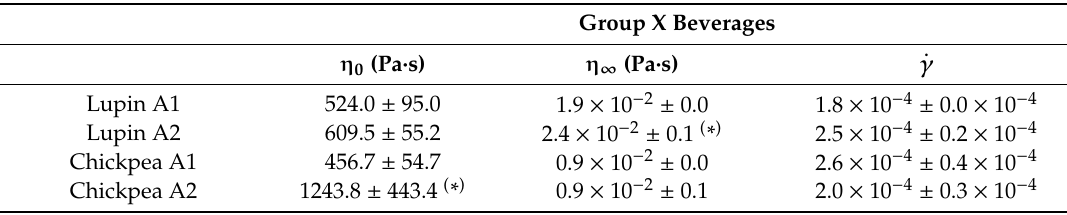
Table 4. Parameters obtained after fitting the flow curves to the Carreau model for all Group X beverages . γ ( η 0 —zero-shear viscosity; η ∞ —infinite-shear viscosity and c—critical shear rate). The superscript (*) indicates the beverage(s) that di ff er from the largest number of the others (12–13 beverages), per parameter ( p < 0.05). Values are represented as mean ± standard